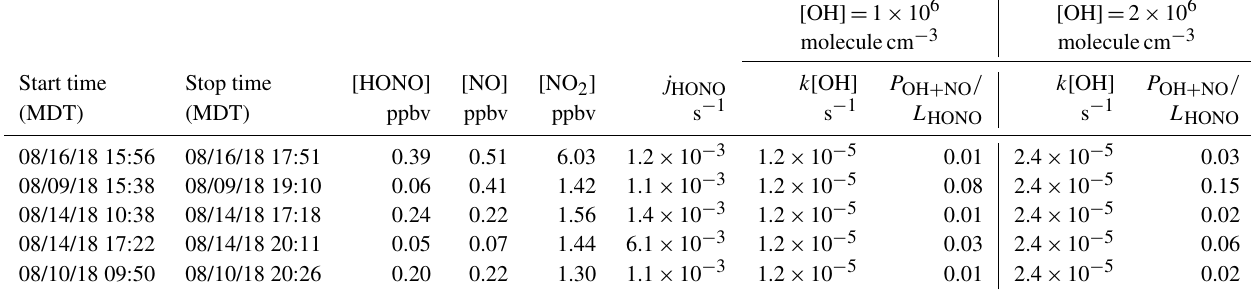
Table A1. HONO budget